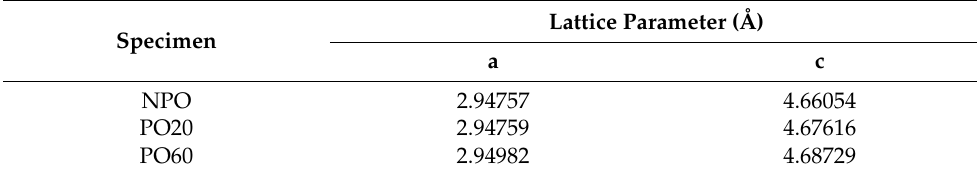
Figure 11. XRD diffraction peaks of α -Ti (103) crystal plane of NPO, PO20, and PO60 specimens. Table 5. Calculation results for lattice parameters of α -Ti.